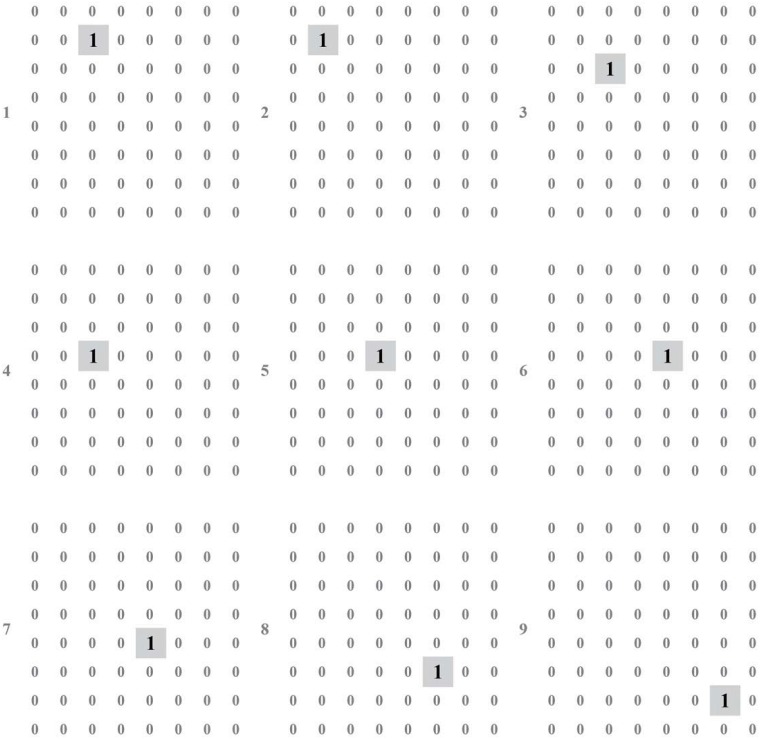
Output of layer 3.